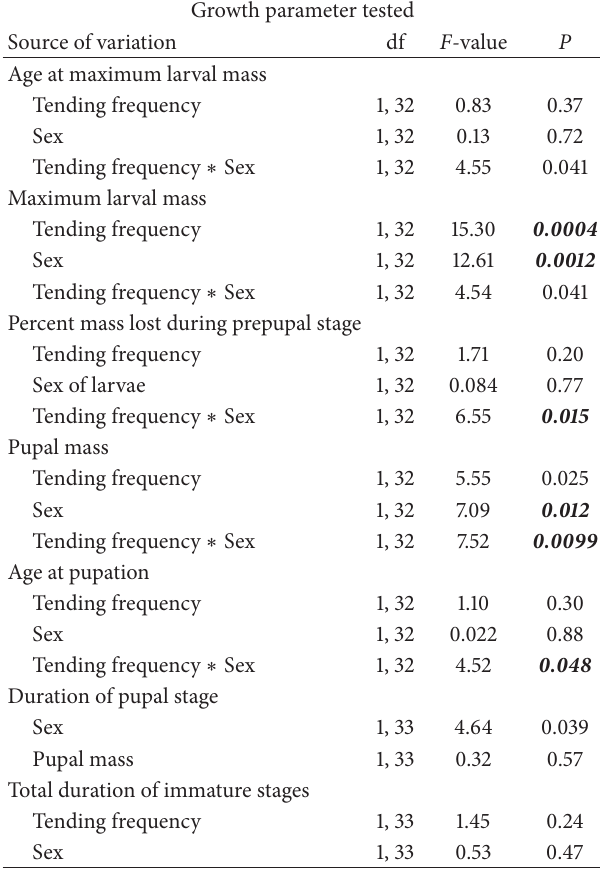
Table 2: Results of linear mixed-effects model testing the effects of ant tending frequency and sex on growth parameters of Miami bluebutterflylarvae.Non-significantinteractiontermswereomitted from some models to better estimate the effects of tending frequency and sex of larvae on growth responses. Uncorrected P -values are presented; test results lower than the table-wide false discovery rate for the corresponding predictor variable are indicated in bold italic